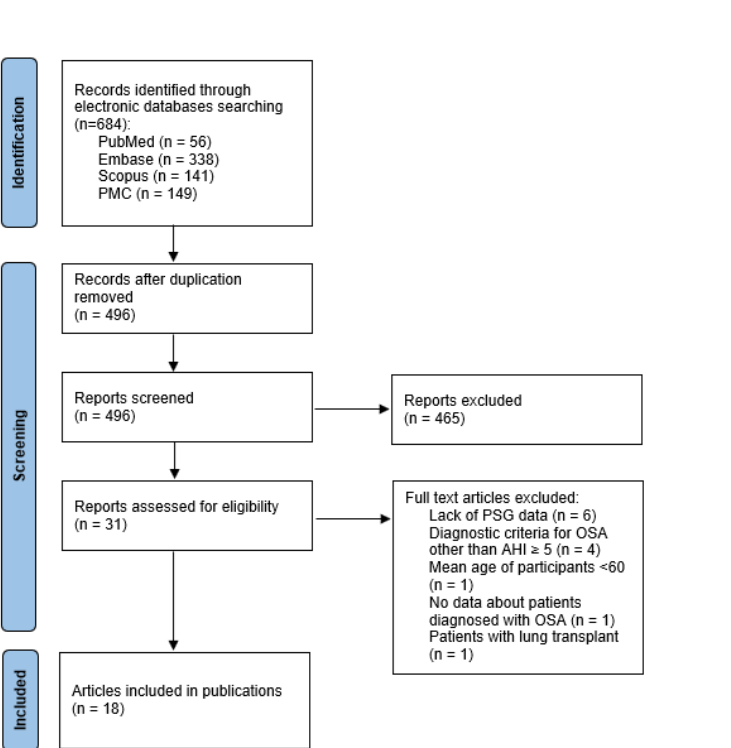
Figure 1. PRISMA flow chart. Legend: AHI, apnea–hypopnea index; PSG, polysomnography; PMC, PubMed Central; OSA, obstructive sleep apnea.